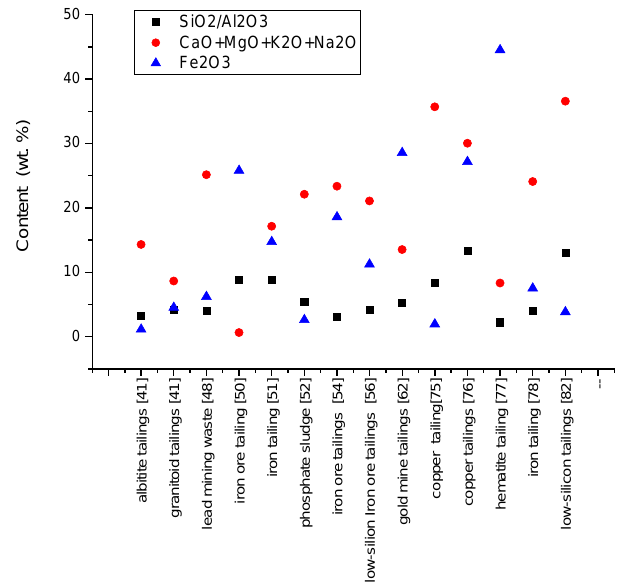
Figure 4. Ratio of SiO 2 /Al 2 O 3 , Fe 2 O 3 and fluxing materials.